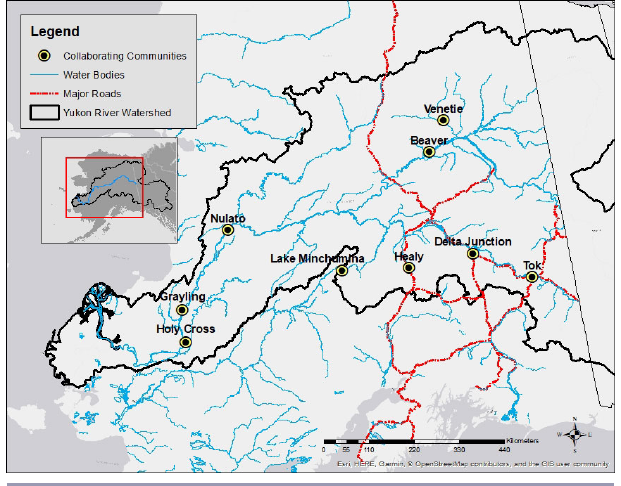
Fig. 1 . Map of project study area depicting the nine collaborating communities across the Yukon River